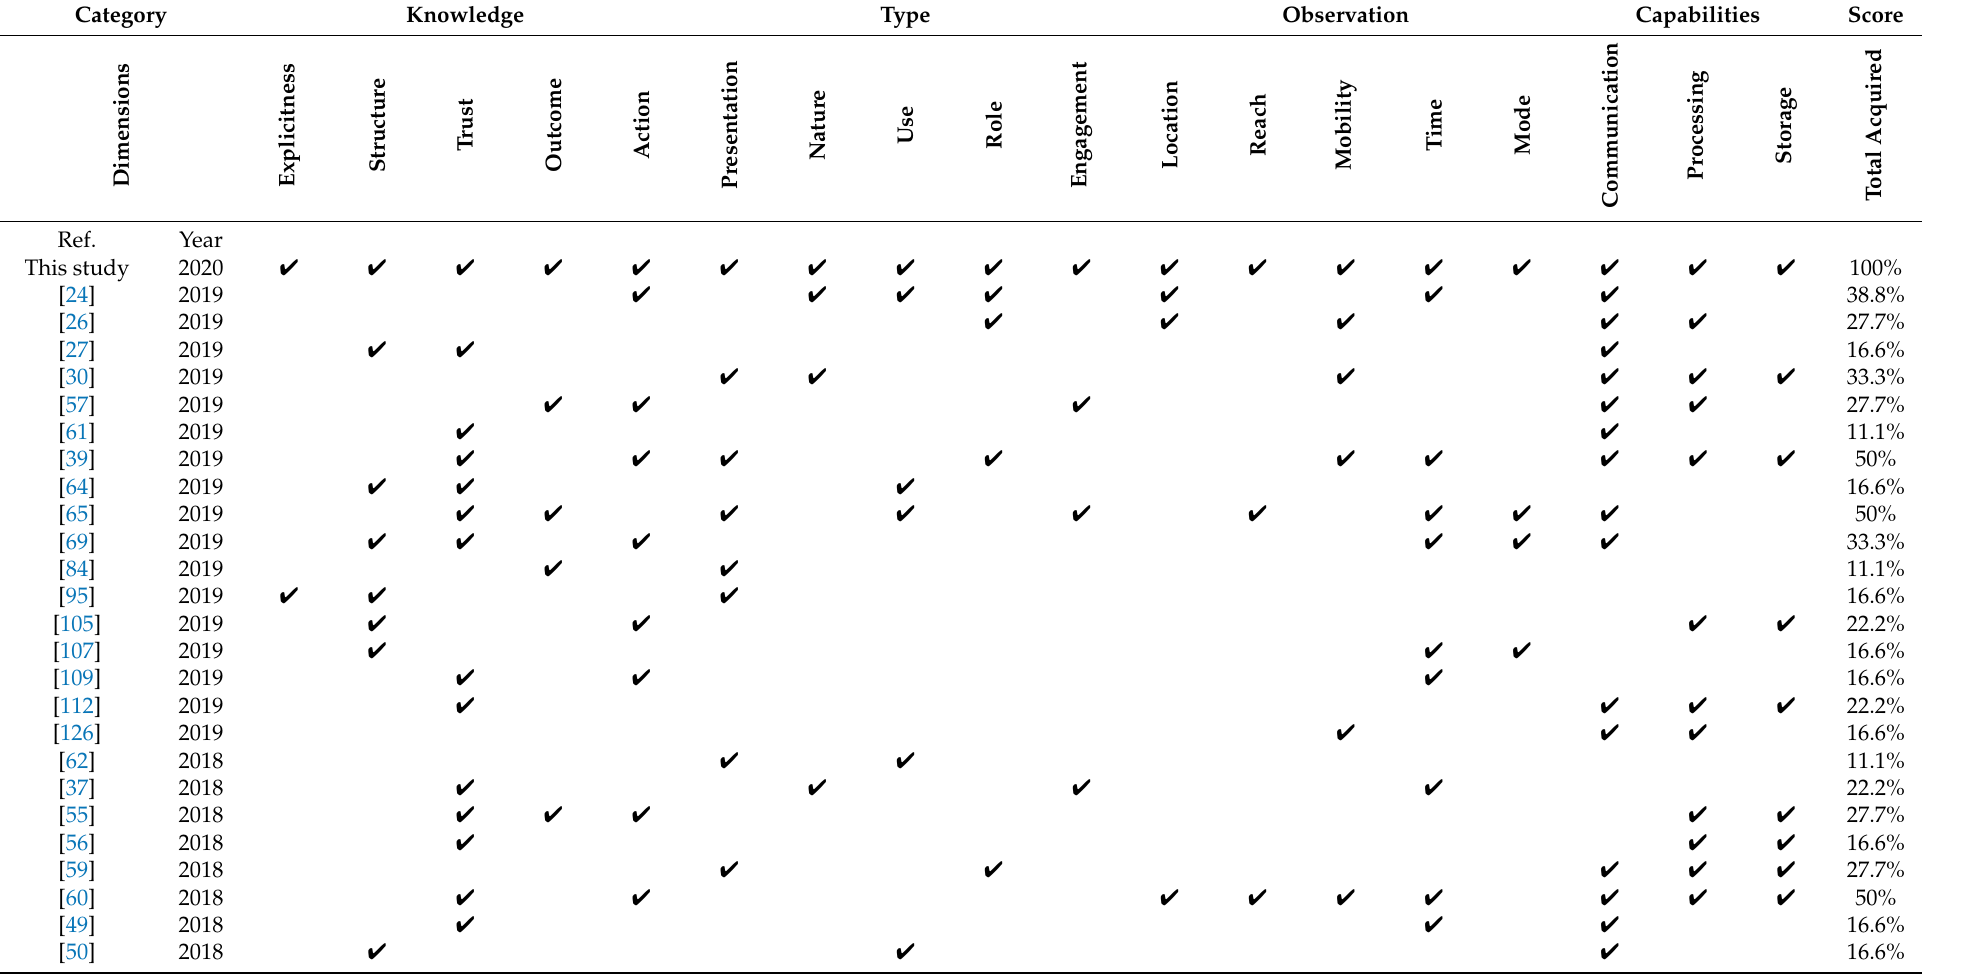
Table 2. Comparison of the scope of the proposed IoE taxonomy with previous works. Knowledge Type Observation